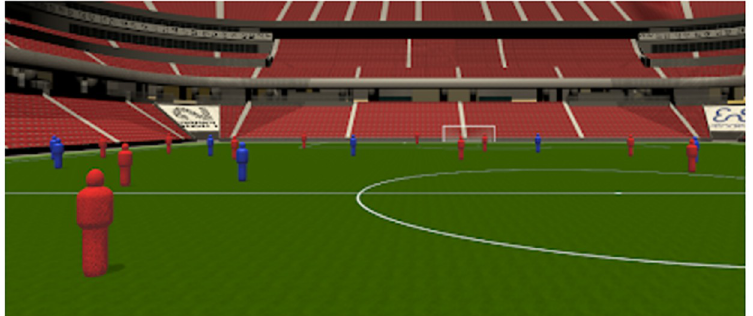
Fig 1. Screen capture of the soccer virtual environment. Virtual soccer players are presented as mannequins in blue for the defenders and in red for the attackers.